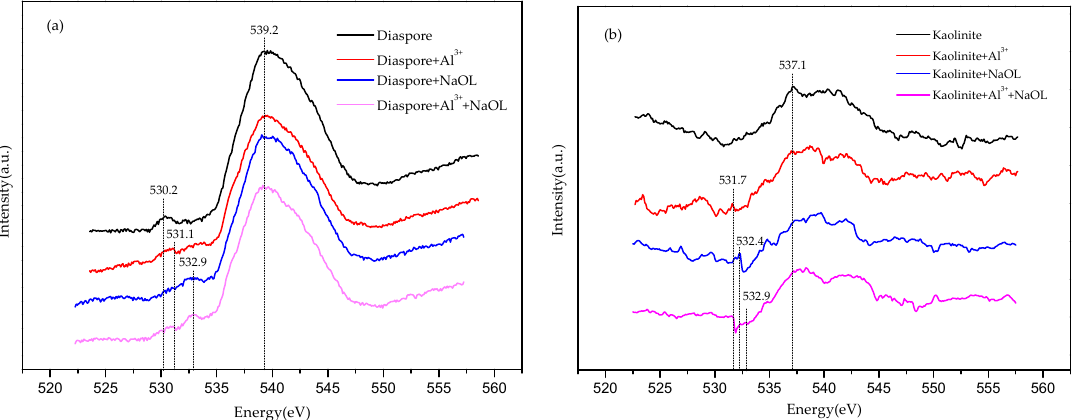
Figure 9. O 1s NEXAFS total electron yield spectra of: ( a ) diaspore and ( b ) kaolinite (pH = 9).